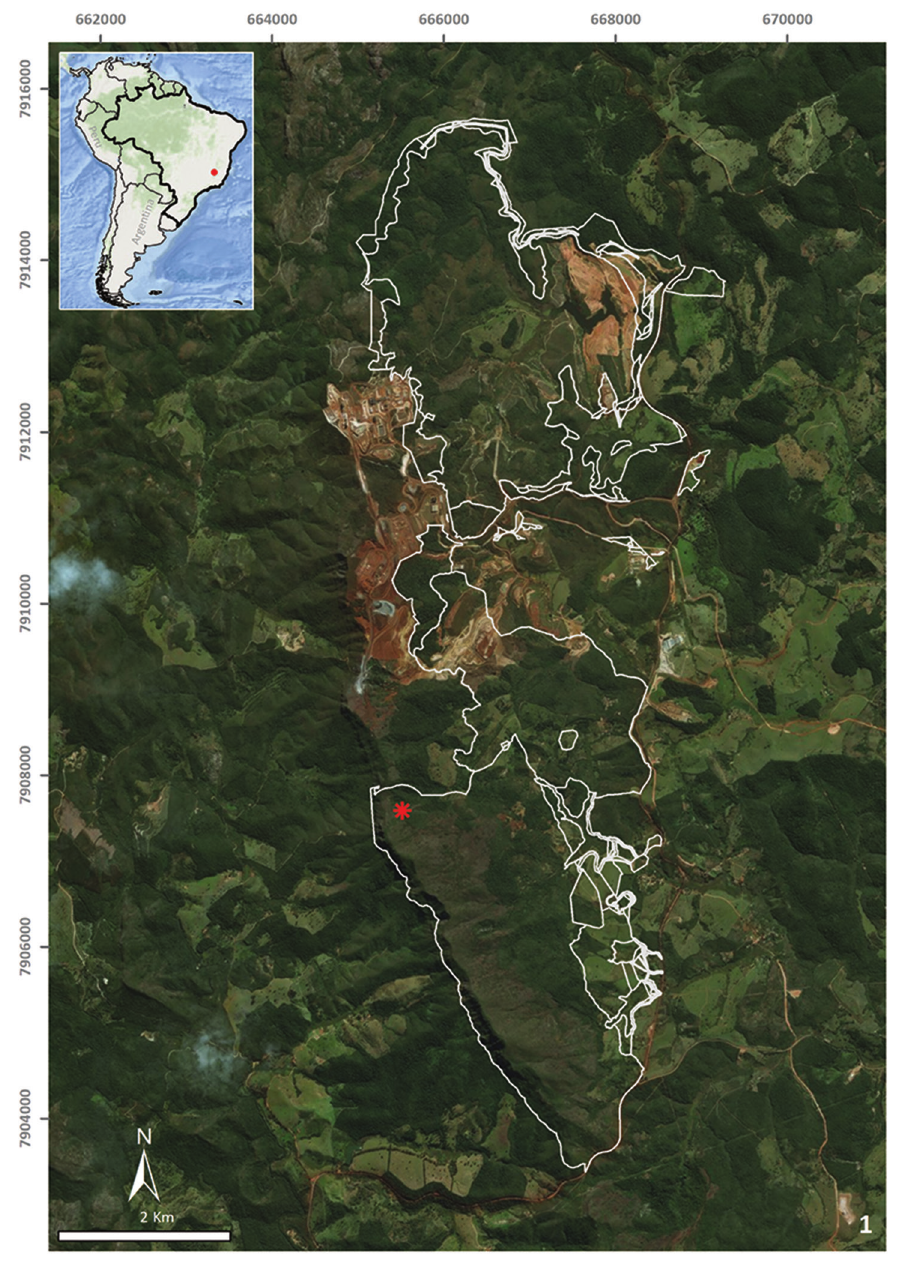
Figure 1. Location of the type locality of Pasipha ferrariaphila sp. n., represented by a ferruginous cave, Conceição do Mato Dentro, state of Minas Gerais, Brazil. The asterisk indicates the cave location; the outline indicates areas impacted by mining exploitation